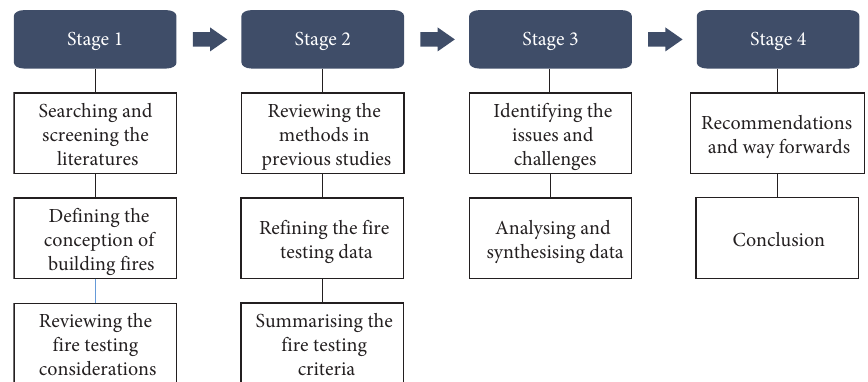
Figure 1: Framework of the review